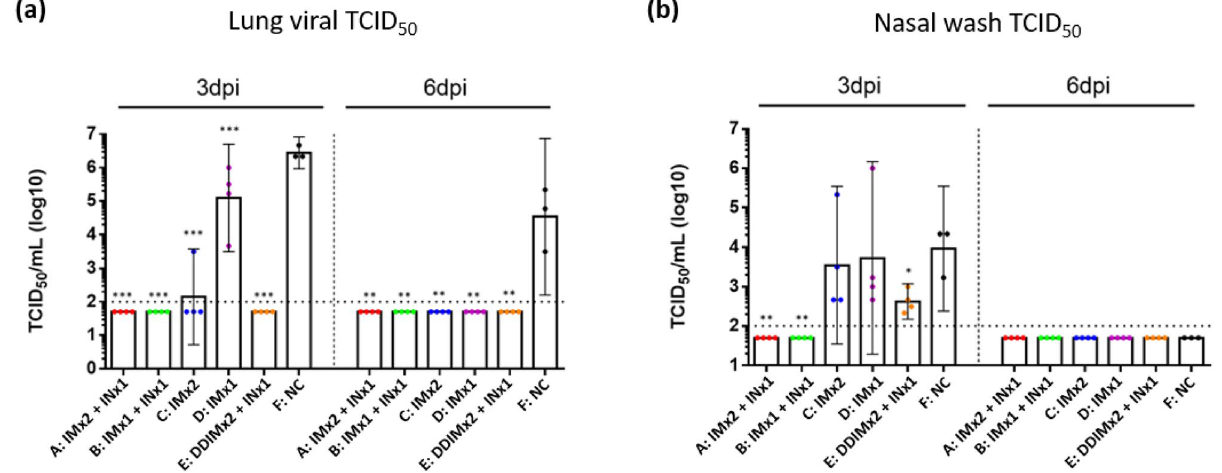
Figure 5. Tissue culture infectious dose (TCID 50 ) from ( a ) lung homogenates; ( b ) nasal wash of hamsters at day 3 and 6 post-SARS-CoV-2 infections. Results are presented as the geometric mean values. Differences between negative control group and other experimental groups of animals were analyzed by student’s t test; * p < 0.05, ** p < 0.01, *** p < 0.001. Dotted line: limit of